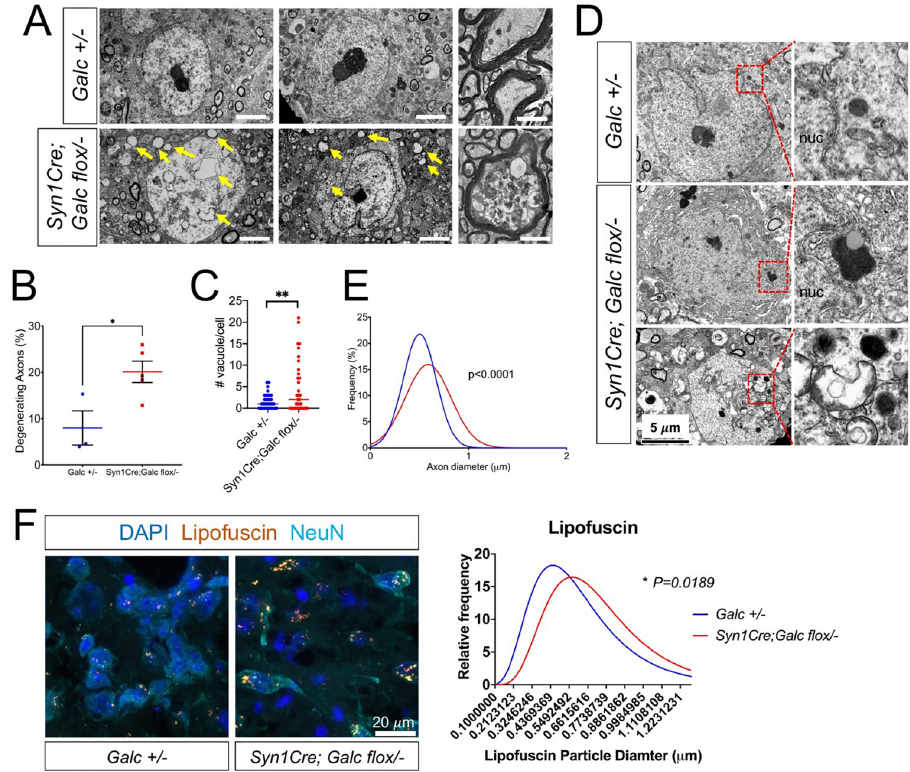
Fig 4. Neuron-specific Galc brains have morphological signs of neurodegeneration. ( A ) Electron microscopic analysis of the cervical spinal cords from Syn1Cre; Galc flox/− and control displayed an increased number of degenerating axons that contained many vacuoles (yellow arrows), compared to control ( Galc + /− ). Scale bar = 4 μ m. ( B ) Quantification of degenerating axons showed that 20.1% of axons were degenerating in the mutant spinal cords, whereas only 7.8% of control axons had a degenerating phenotype. ( C ) Galc- deficient neuronal cells had a significant increase of vacuoles in the cytoplasm (yellow arrows in A ) as compared to WT neurons. ( D ) Electron micrographs of mutant neurons and lysosomes (inset boxes in left panels and at higher magnification in right panels) show abnormal lysosomal morphology and inclusions in the neurons of Syn1Cre; Galc flox/− . nuc, nucleus. ( E ) The distribution of axon diameters was also significantly changed in the Syn1Cre; Galc flox/− mice, with a rightward shift, indicating larger axons. Data are presented as mean values ± SEM; � P < 0.05, �� P < 0.01, ��� P < 0.001, and ns, not significant. N = 3 for Galc +/− and 5 for Syn1Cre; Galc flox/− . ( F ) The signal of lipofuscin, a granule composed of lipid-containing residues of lysosomal digestion, was significantly increased in the neurons (NeuN) of 6-month-old Syn1Cre; Galc flox/ − mice. The underlying data for B , C , E , and F can be found in S1 Data. GALC, galactosylceramidase; WT,